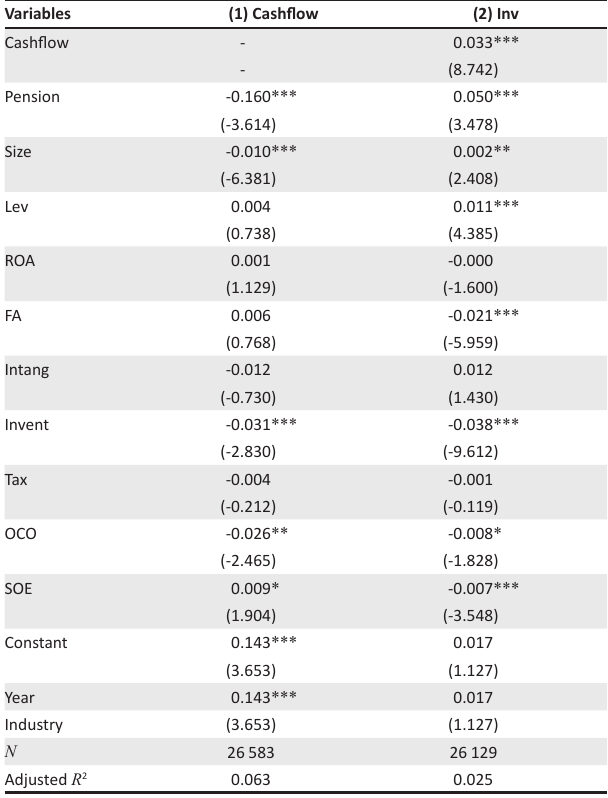
TABLE 6: Association between defined pension contributions and investment inefficiency. Variables